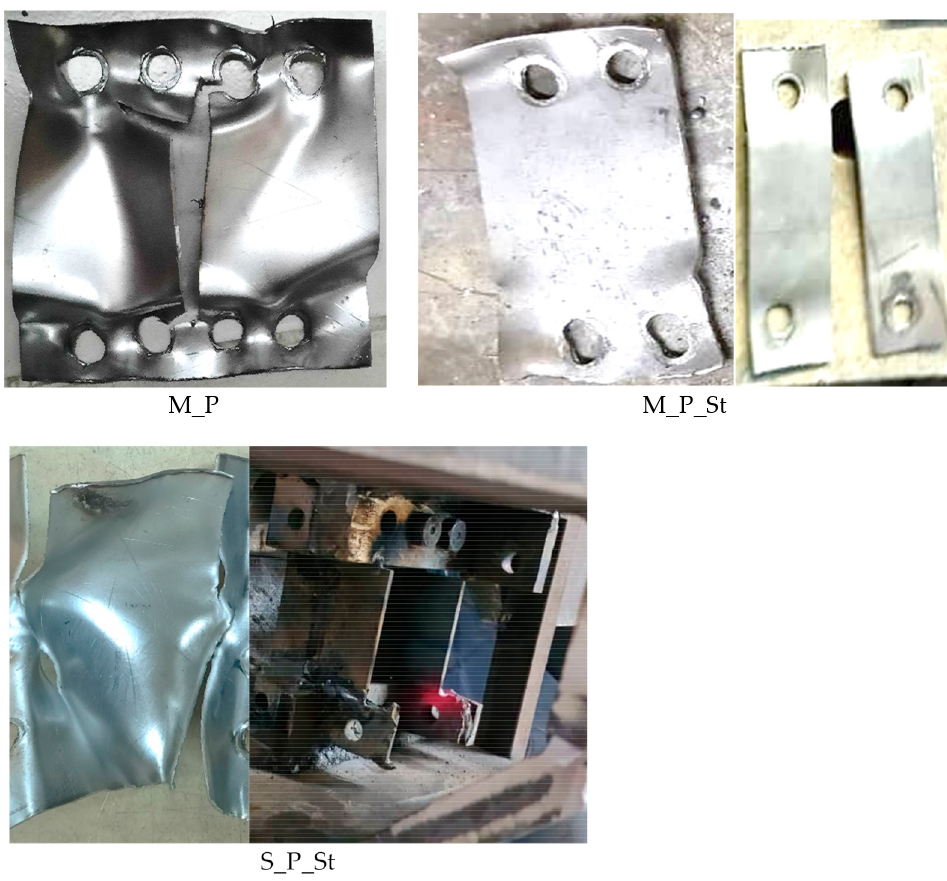
Figure 6. Tearing of the